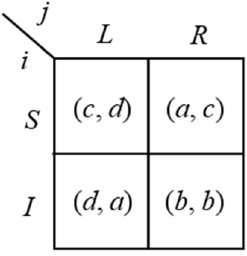
Figure 1. Original game G with one equilibrium confirmed